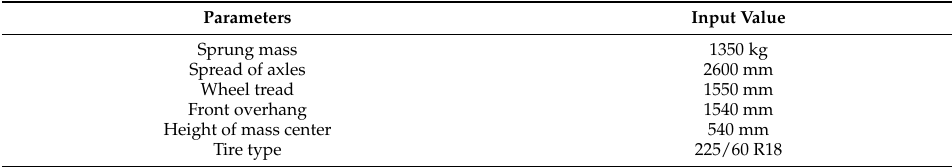
Figure 4. Vehicle parameters setting. Table 3. Main parameters of vehicle model. Table 3. Main parameters of vehicle model.